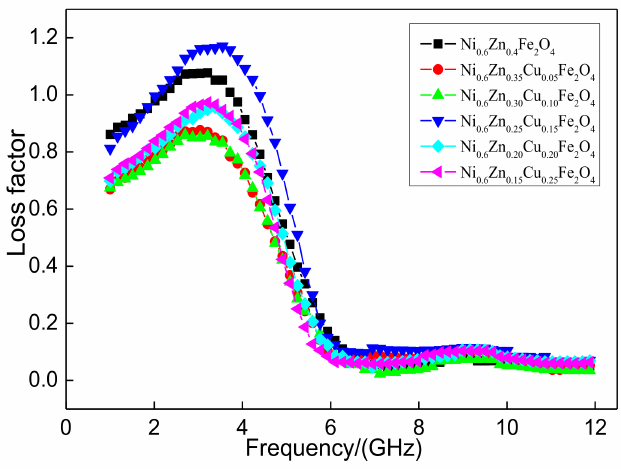
Figure 11. Curves of tan δ and frequency for the Ni 0.6 Zn (0.4 − x) Cu x Fe 2 O 4